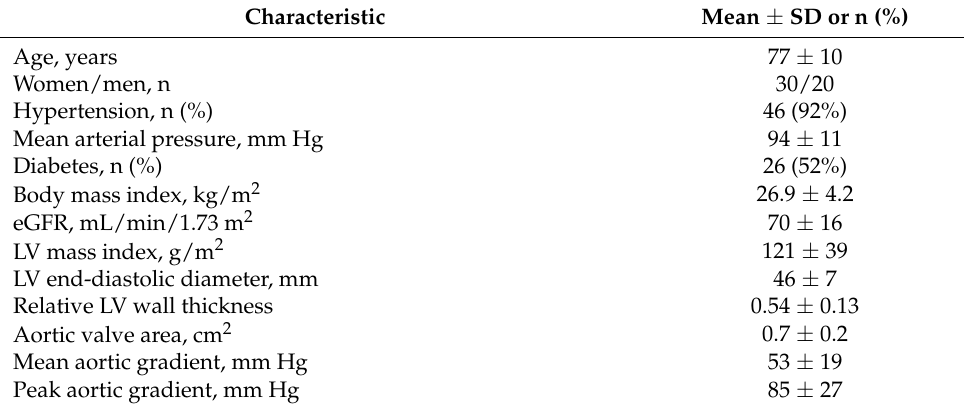
Table 1. Patients’